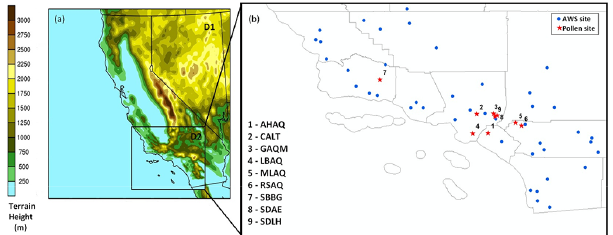
Fig. 2. (a) Domain coverage of the 12km California (D1) and 4km southern California (D2) grids with terrain height; and (b) the loca- tion of pollen sampling sites (red) and the AWS sites